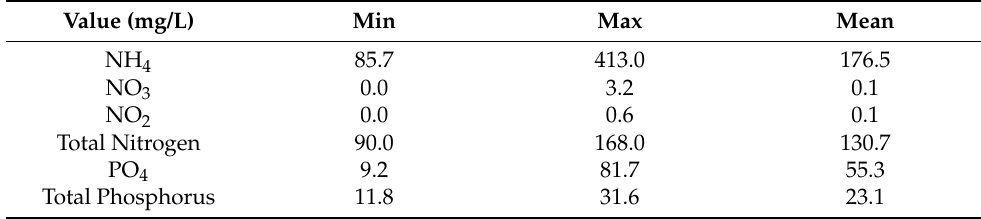
Table 2. Concentration of biogenic substances of raw sewage in the outflow of the septic